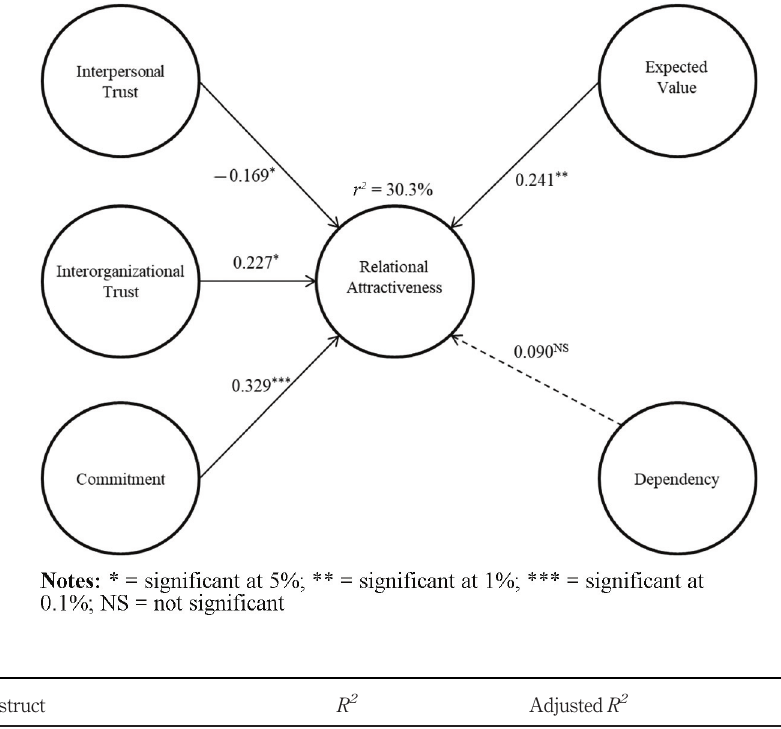
Table 4. Results of R 2 ,